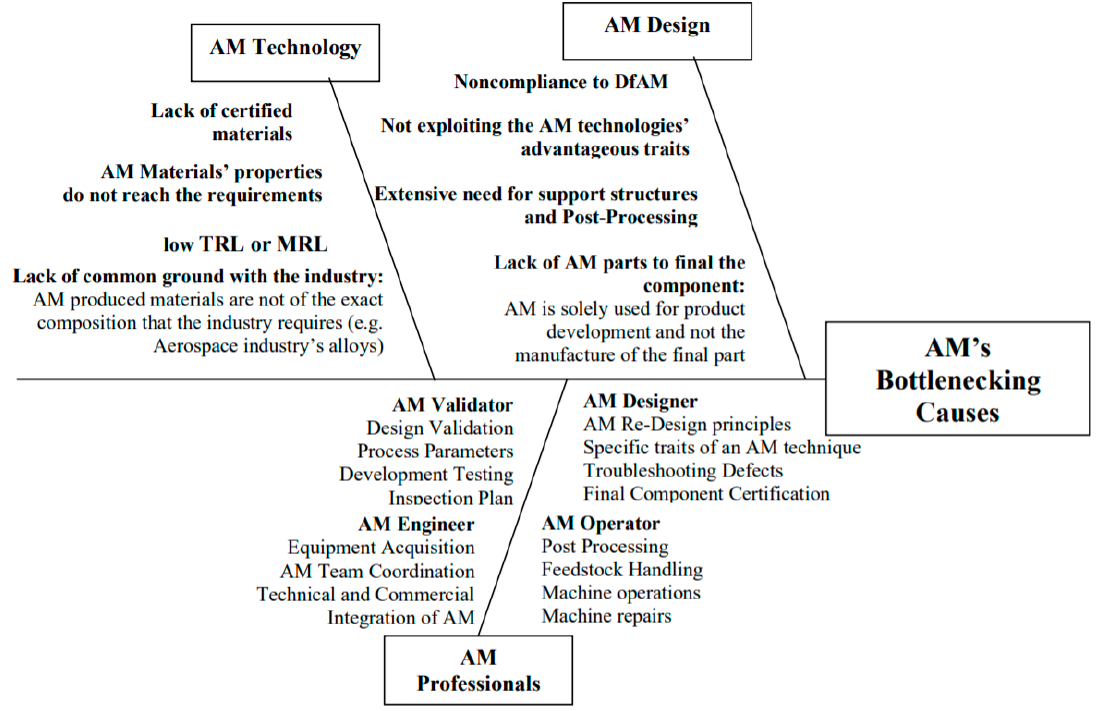
Figure 1. Ishikawa diagram presenting the crucial factors that affect AM production and its industrial uptake [31,32,33].